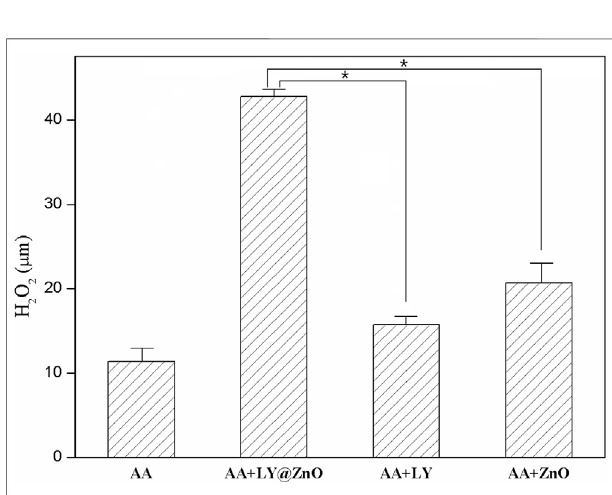
FIGURE 11 | UV spectra of LY@ZnO mixed with TMB at different times.